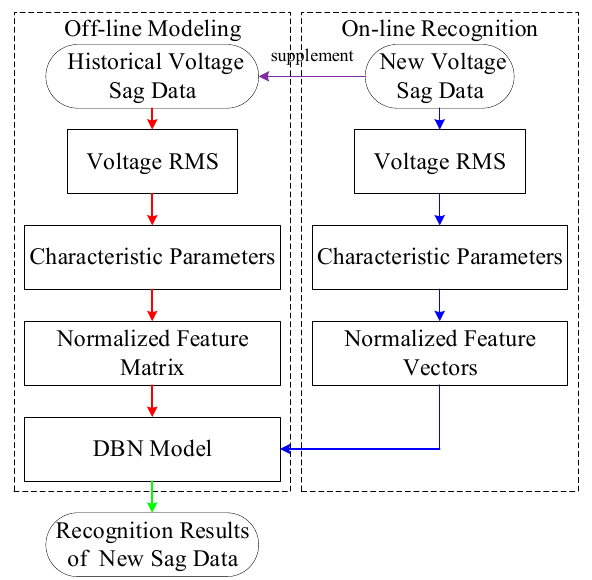
Figure 8. Online voltage sag recognition process.